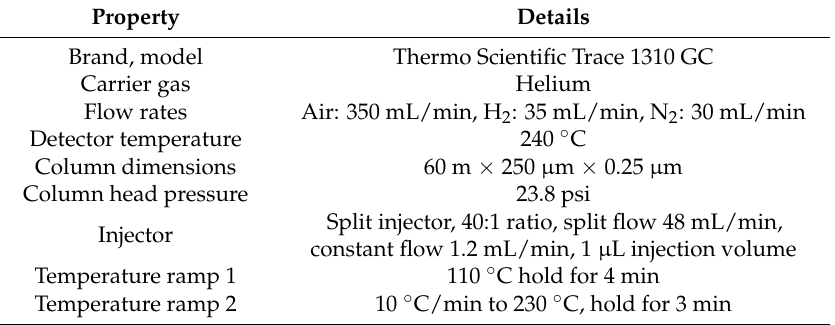
Table 2. Gas chromatograph (GC) operating conditions.